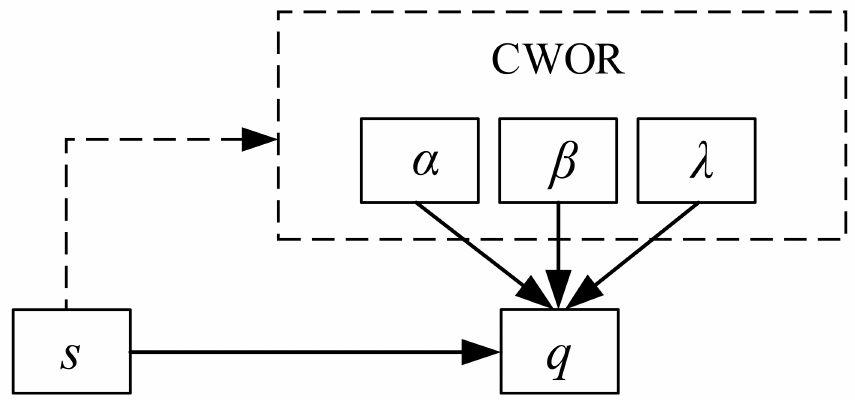
Figure 6. The connection between the game model and empirical